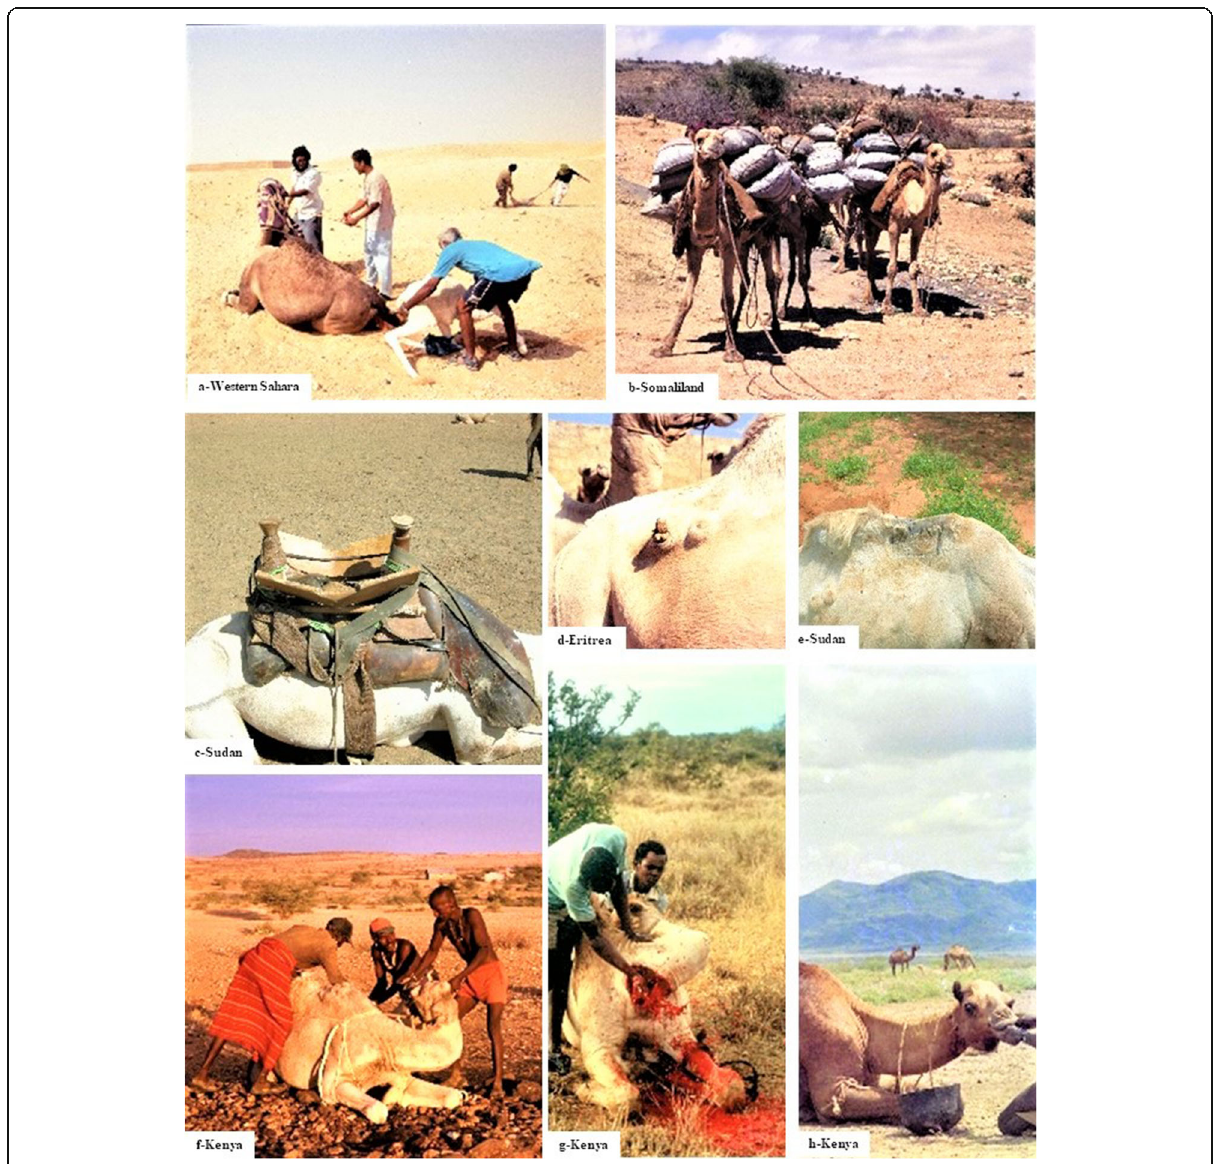
Fig. 10 Images of calf adoption, packing, riding, and slaughtering practices used by nomadic camel pastoralists in a variety of countries (Dioli 2012,2013, Schwartz and Dioli 1992). a Western Sahara. b Somaliland. c , e Sudan. d Eritrea. f – h